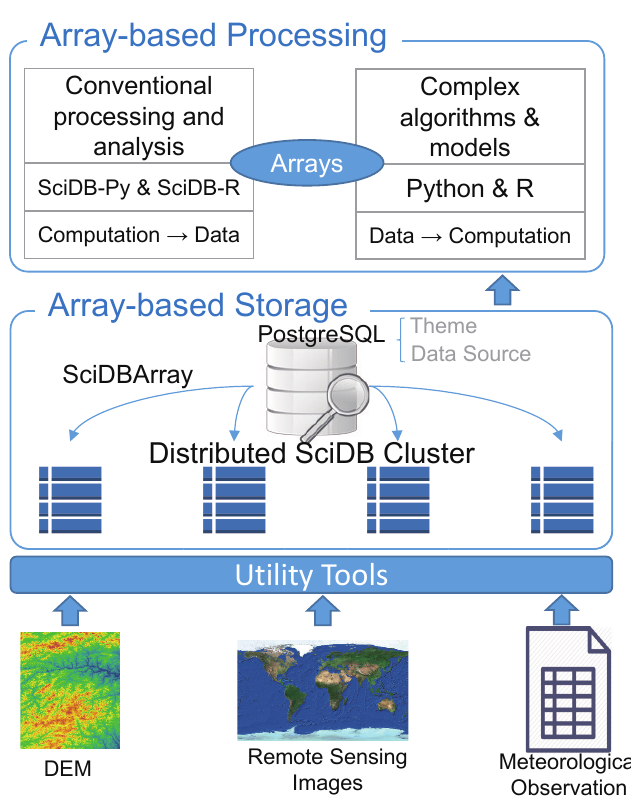
Figure 4. System architecture for EO data management and